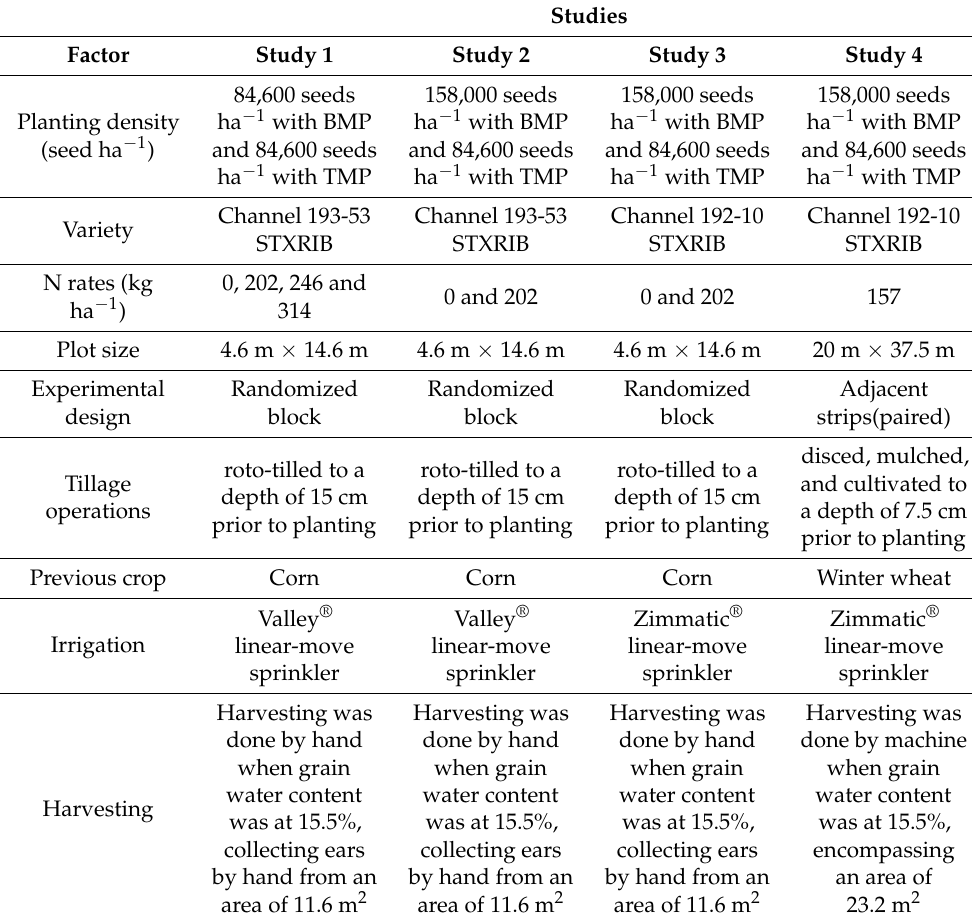
Table 1. Summary of the main treatments and management factors in the four independent studies comparing the traditional method of planting (TMP) in 76.2 cm rows with a lower plant popula- tion to the best management practice (BMP) of planting in 38.1 cm (narrow) rows with a higher plant population